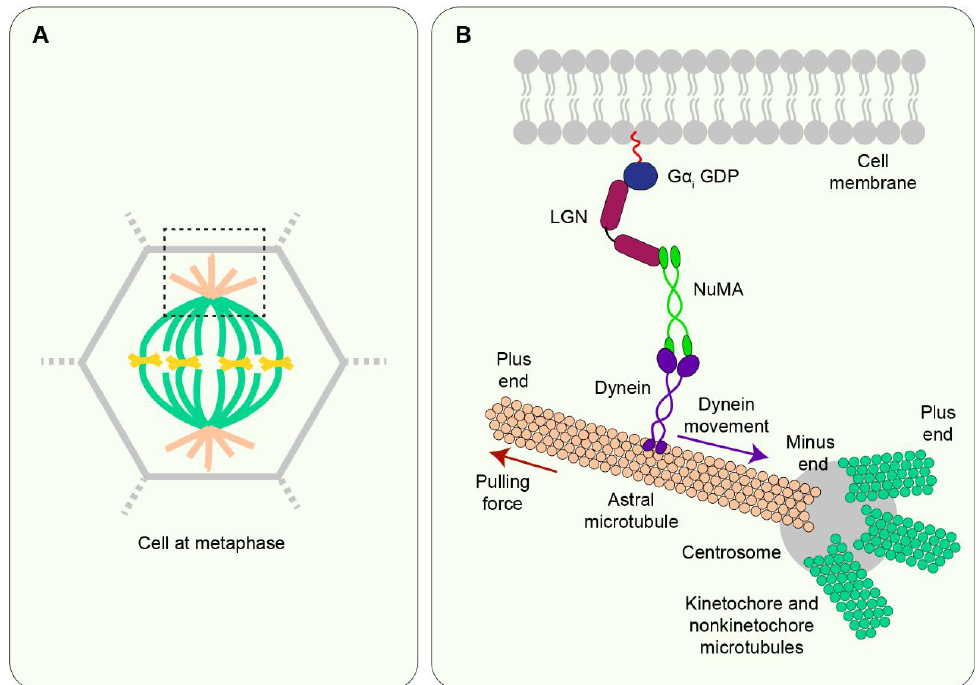
Figure 6. The spindle orientation machinery in vertebrates. ( A ) A schematic of a cell at metaphase is shown. The region selected by the black box is enlarged in B. ( B ) At interphase, NuMA is restricted within the nucleus but at the onset of mitosis, NuMA is carried to the minus end of microtubules (near the centrosomes) by dynein. Near this region, NuMA binds to LGN which, in turn, binds to Gα i GDP which is tethered to the membrane. This forms the cortically localised NuMA/dynein-LGN- Gα i complex. Dynein, due to its minus end-directed mobility, walks along astral microtubules towards the centrosomes. However, cortical localisation of the protein complex opposes dynein motion thereby exerting pulling forces on astral microtubules. These pulling forces then help to orient the mitotic spindle [74].